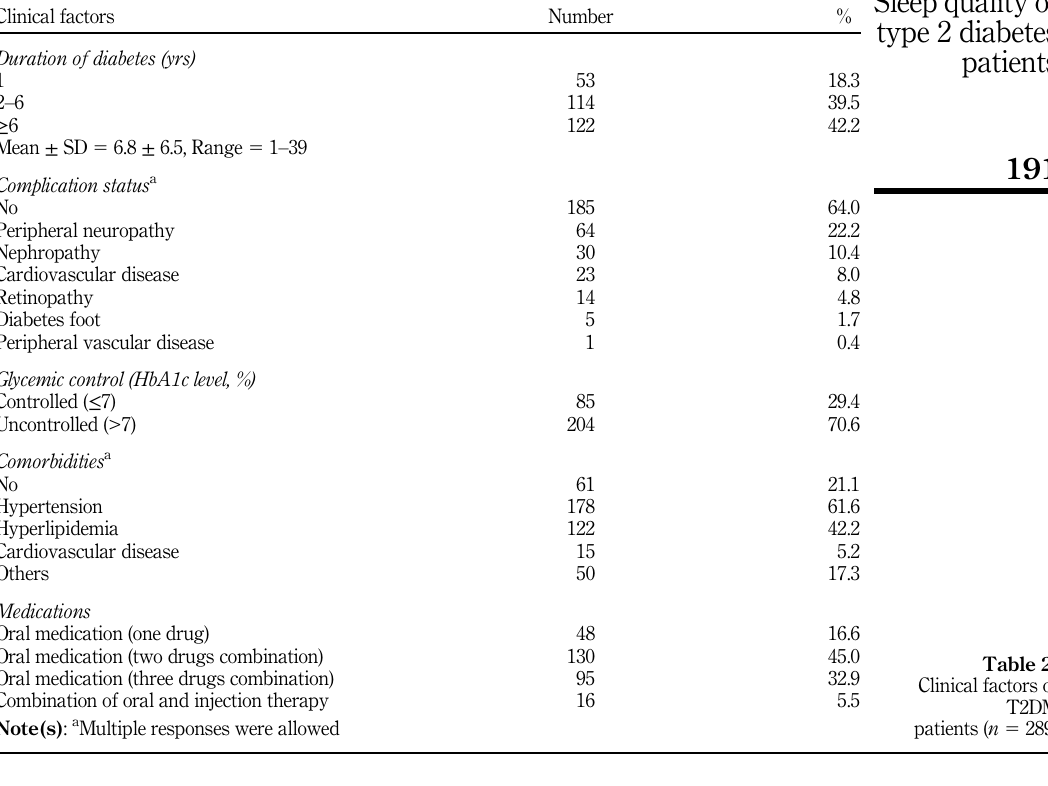
Table 2. Clinical factors of